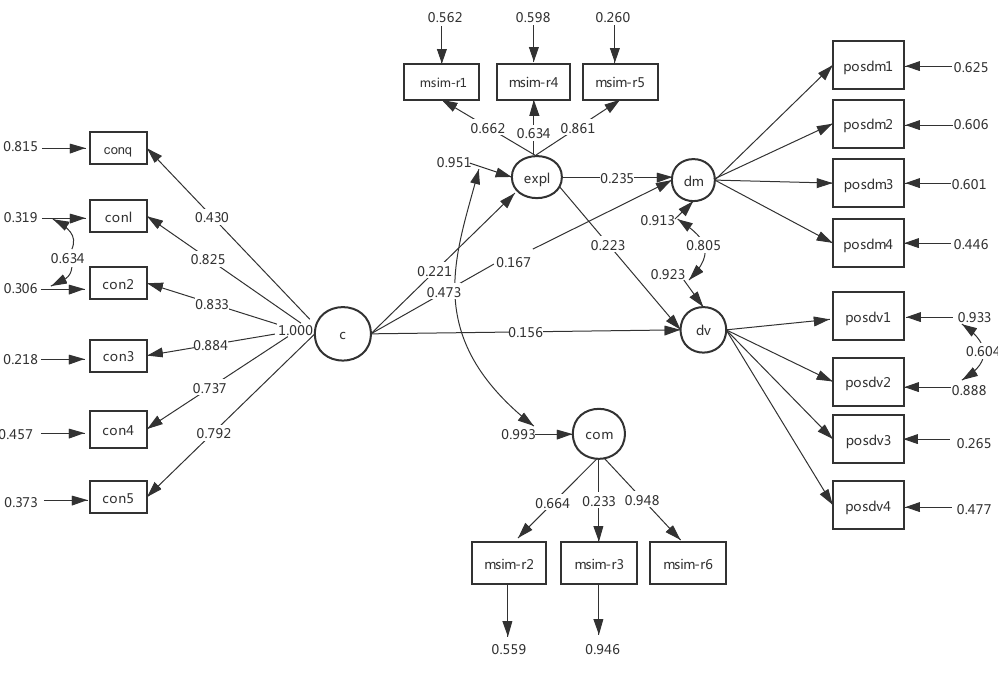
Figure 1. Predicted